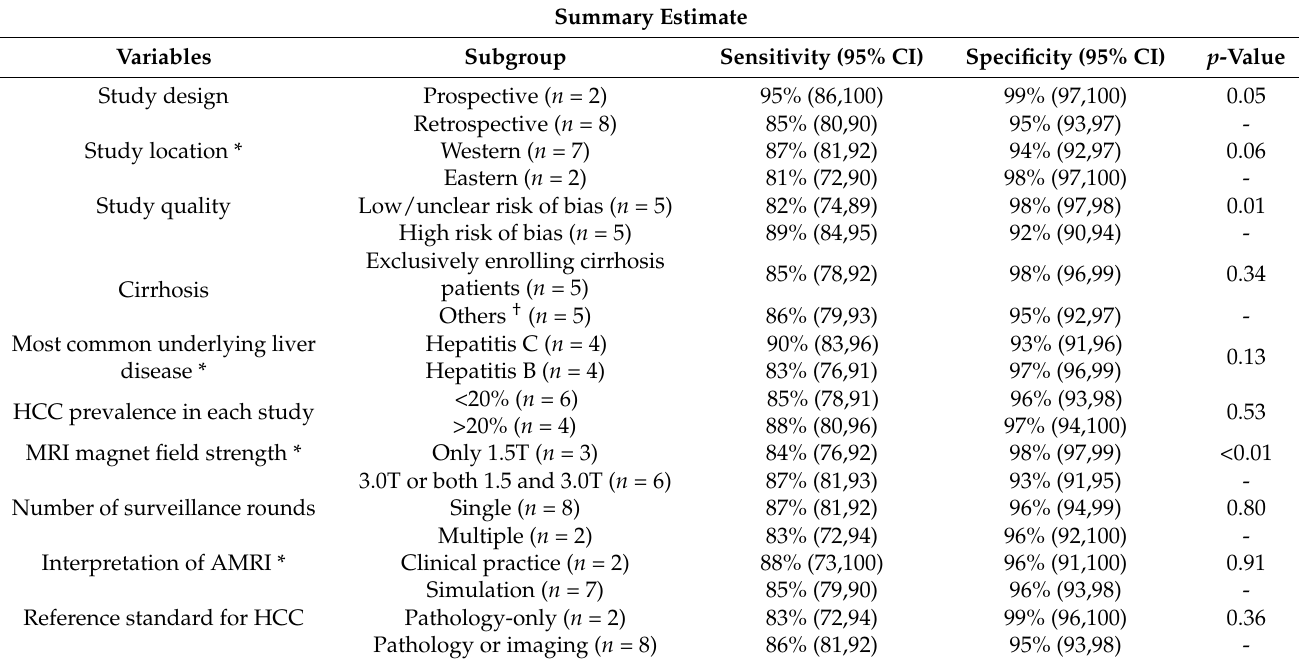
Table 3. Meta-regression analysis of abbreviated MRI for detecting hepatocellular carcinoma. Summary